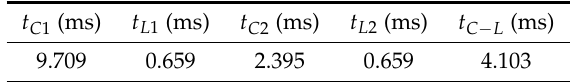
Table 17. Measured calculation times in Equations (12) and